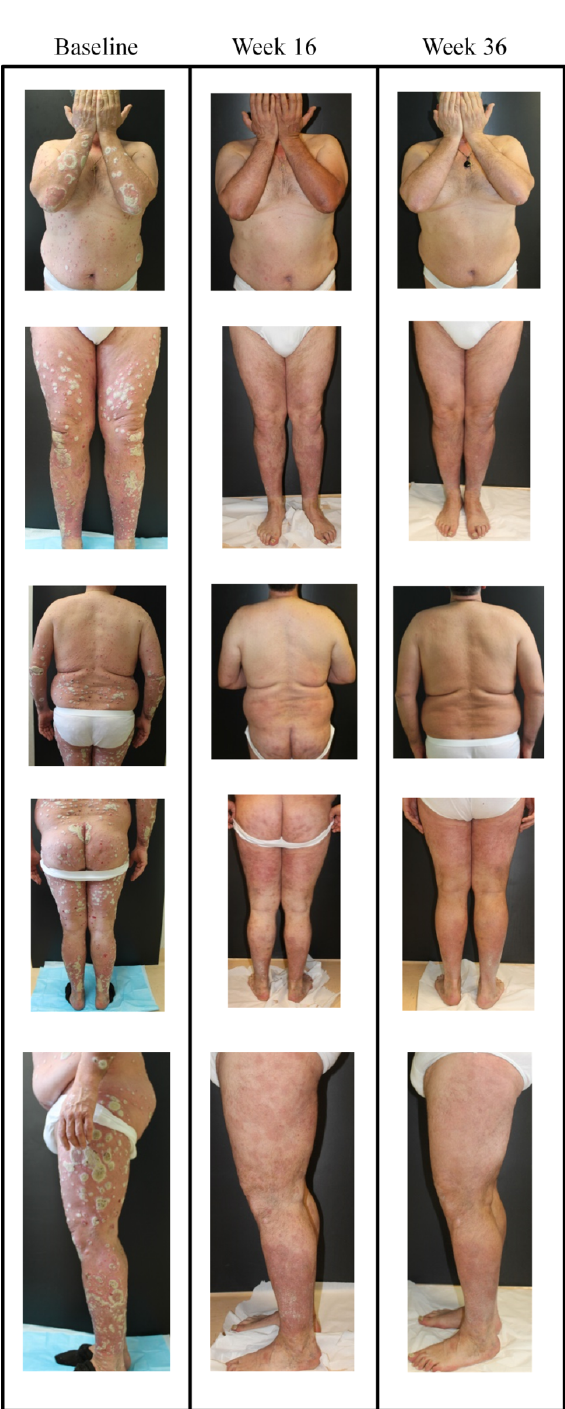
Figure 5. Representative images of outcome in case #2; male, aged 53 years with onset of psoriasis at 24 years of age, cigarette smoker with hypertension. In January 2019 he presented with severe chronic plaque psoriasis. He was not responsive to traditional systemic drugs and anti-TNF α (i.e., multidrug resistant). He was treated with secukinumab from 2016 to 2019, with excellent response over the first year of treatment but loss of efficacy occurred from week 64 of treatment, at which point he was switched to guselkumab. Images at different sites are presented for the time points; baseline, week 16, and week 36. After baseline visit (PASI of 42, guselkumab treatment was initiated (induction phase: 100 mg subcutaneously at weeks 0 and 4, and a maintenance dose every 8 weeks thereafter). After 16 weeks, PASI decreased to 3 and at week 36, PASI decreased to 0.